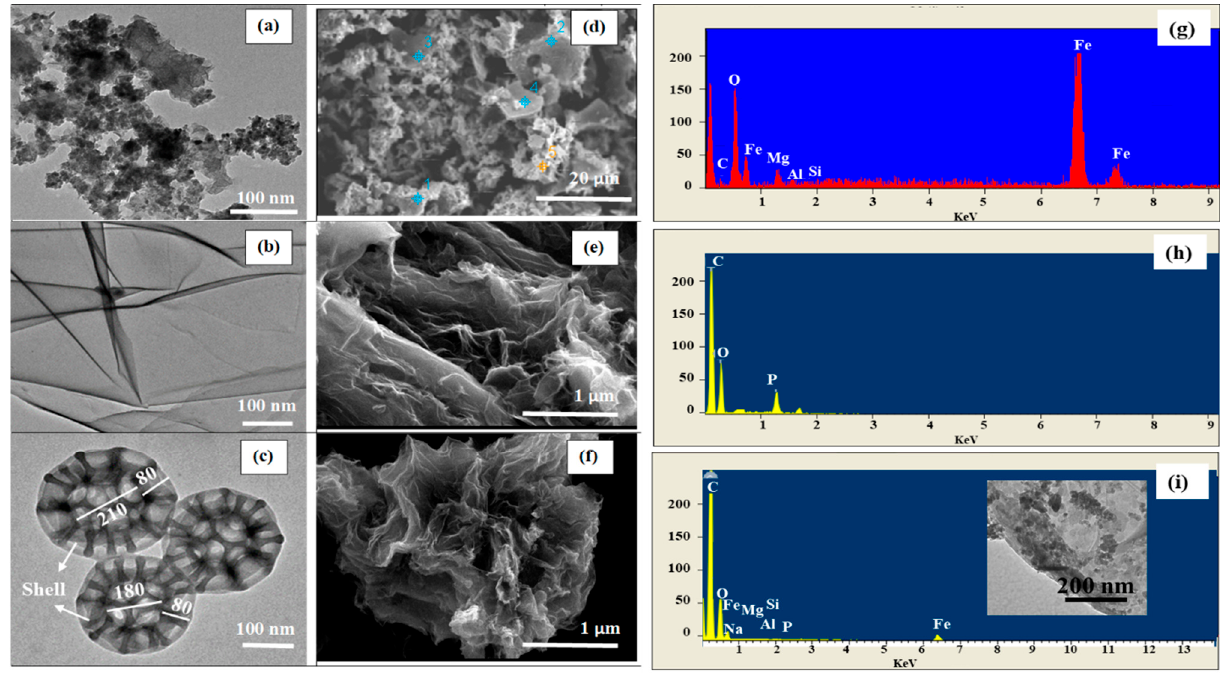
Figure 4. TEM images ( a – c ), SEM images ( d – f ), their EDS pattern ( g – i ) of MGF-B, BPGO and HNFs (Blue and yellow symbols in Figure 4d represents the points used for surface analysis using point and shoot method)